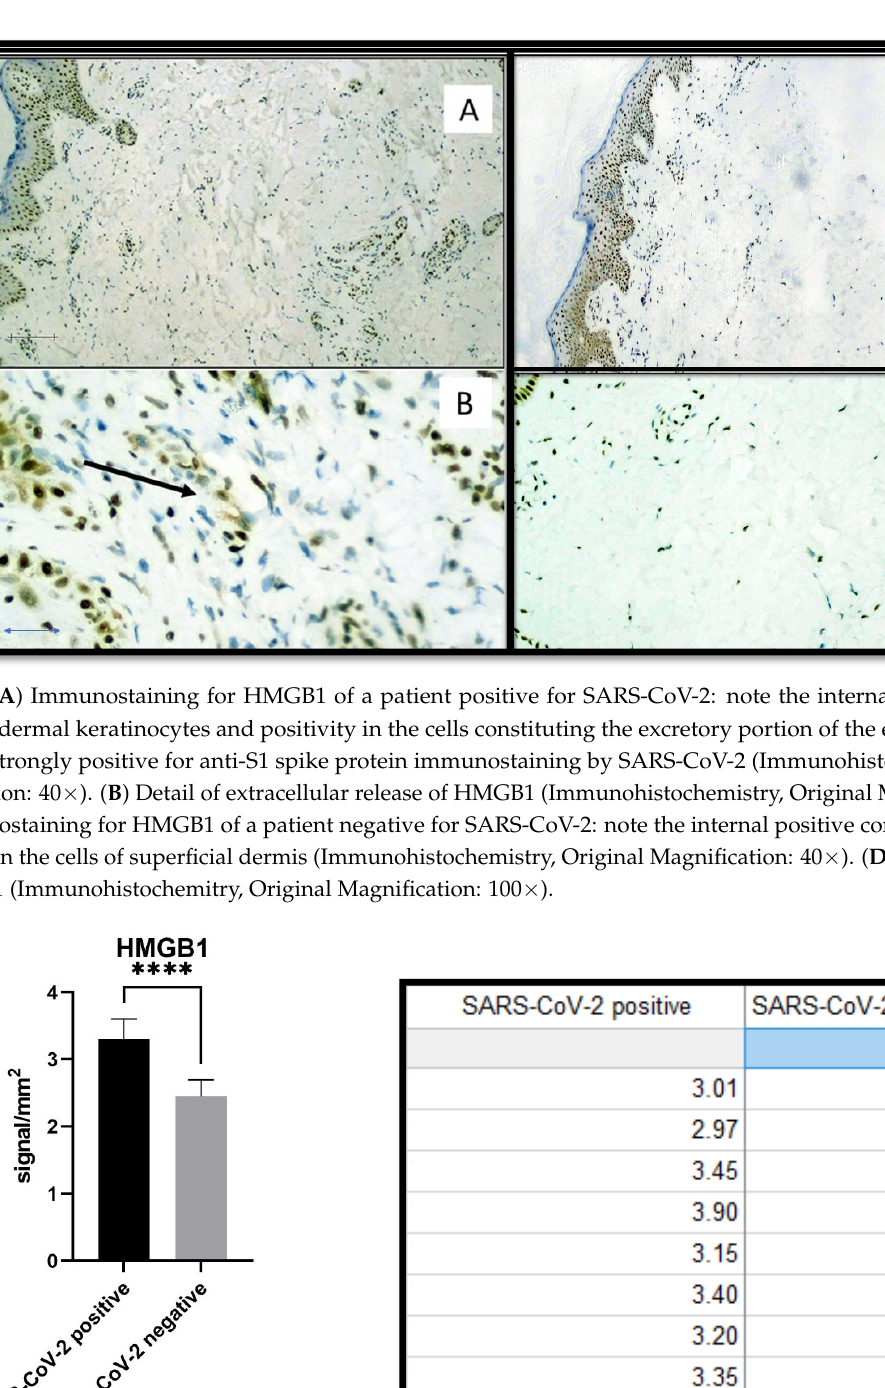
Figure 3. Table and graph relating to the density of CD8+ lymphocytes in the samples of the two groups of studies. Note that, also in this case, there was no statistically significant difference ( p value: 0.4932, >0.05). ns notes not significant.